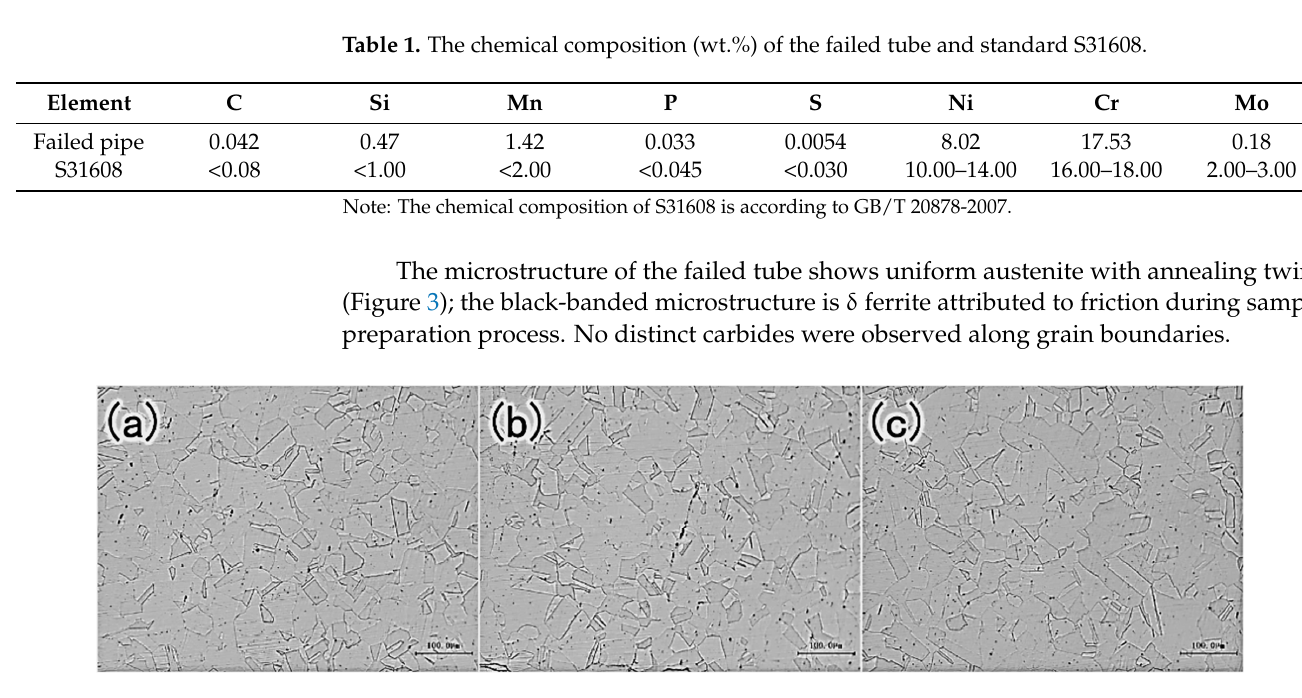
Figure 3. The metallography of tube at different zones ( a ) external tube, ( b ) middle tube and ( c ) internal tube.